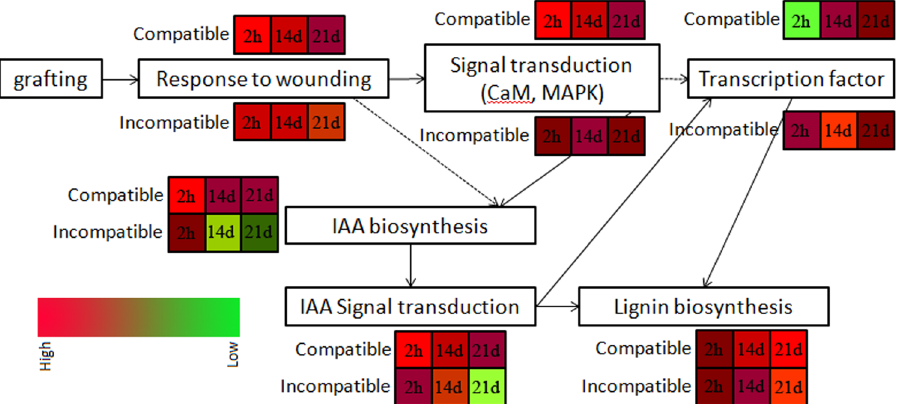
Figure 9. A hypothetical model of graft-union development in compatible and incompatible grafting of litchi. Different colors represent the expression levels of key genes in each pathway of the litchi compatible graft J/J and incompatible graft J/Z at 2 h, 14 d, and 21 d after